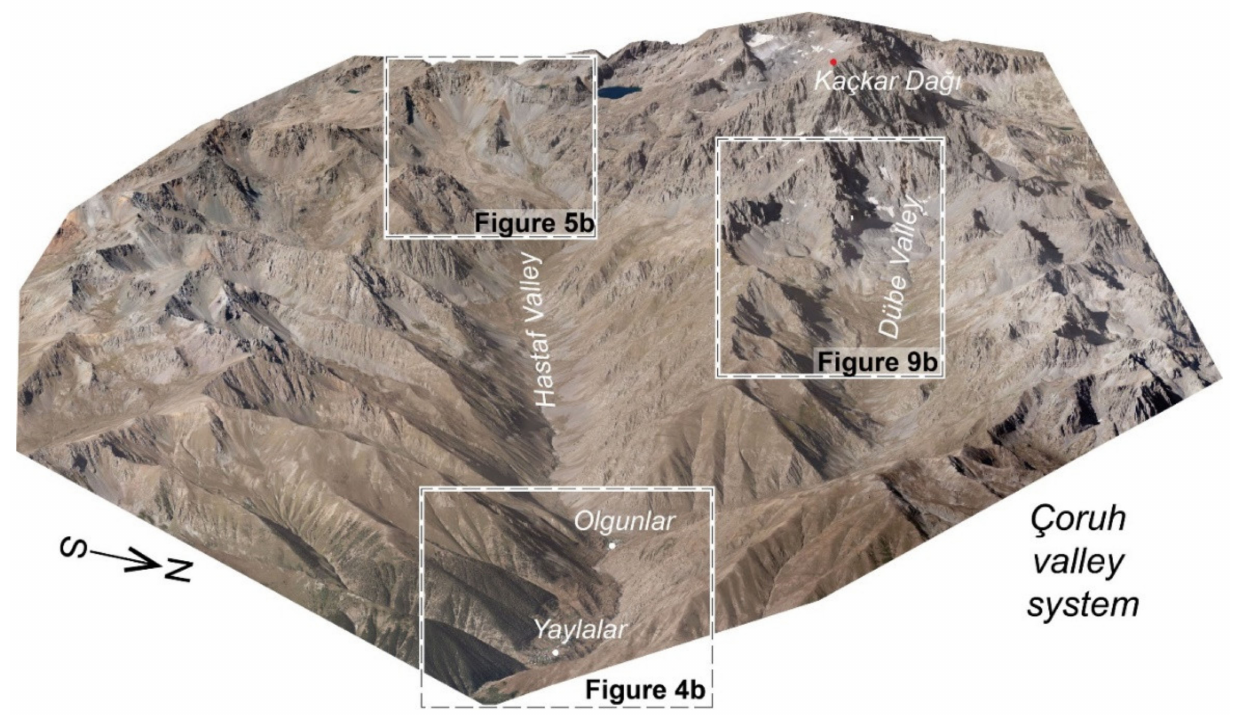
Figure 2. The Çoruh Valley System from an oblique aerial view based on orthophoto, to the east, and southeast of Mt.